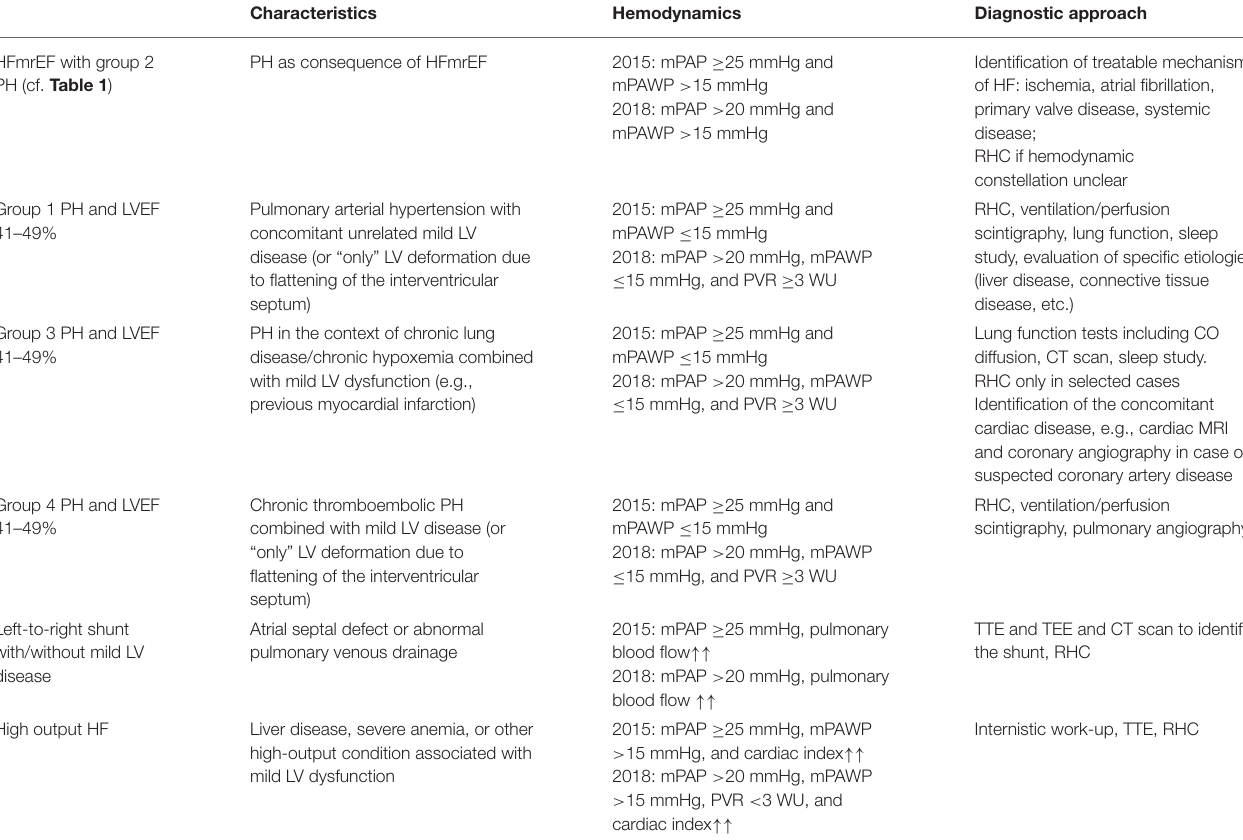
TABLE 4 | Differential diagnosis of pulmonary hypertension (PH) and mid-range/“mildly reduced” left ventricular ejection fraction